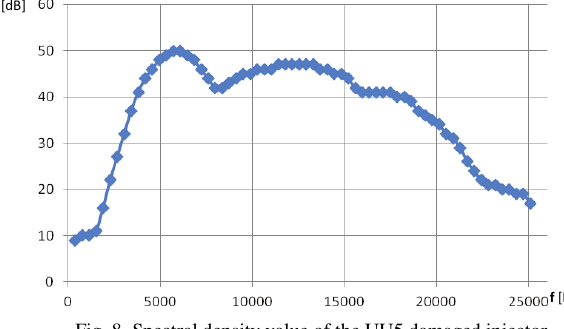
Fig. 8. Spectral density value of the UU5 damaged injector On the graph of spectral density, the undamaged injec- tors have two visible maxima, the amplitude of the second being higher than the first and are in the range of 11–12 kHz. Another situation is in the graph of damaged injectors, where is possible to distinguish three distinct and